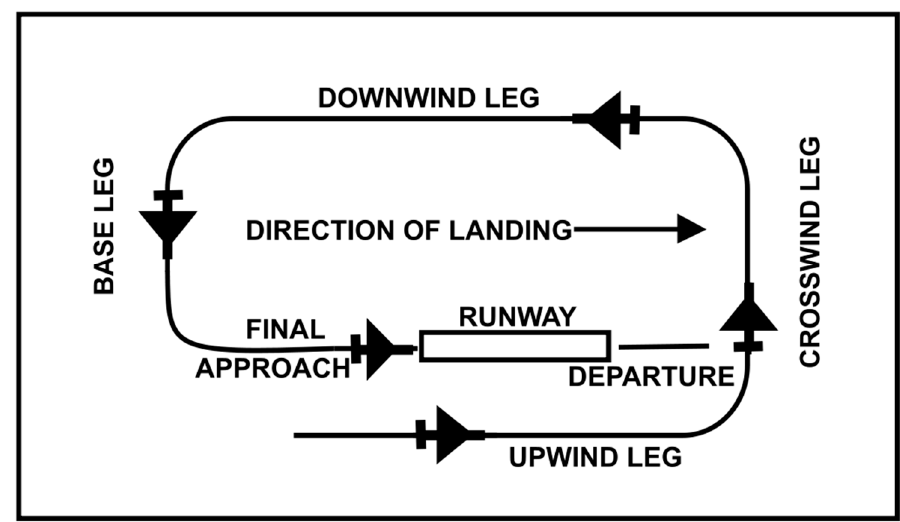
Figure 14. A typical airfield traffic pattern.